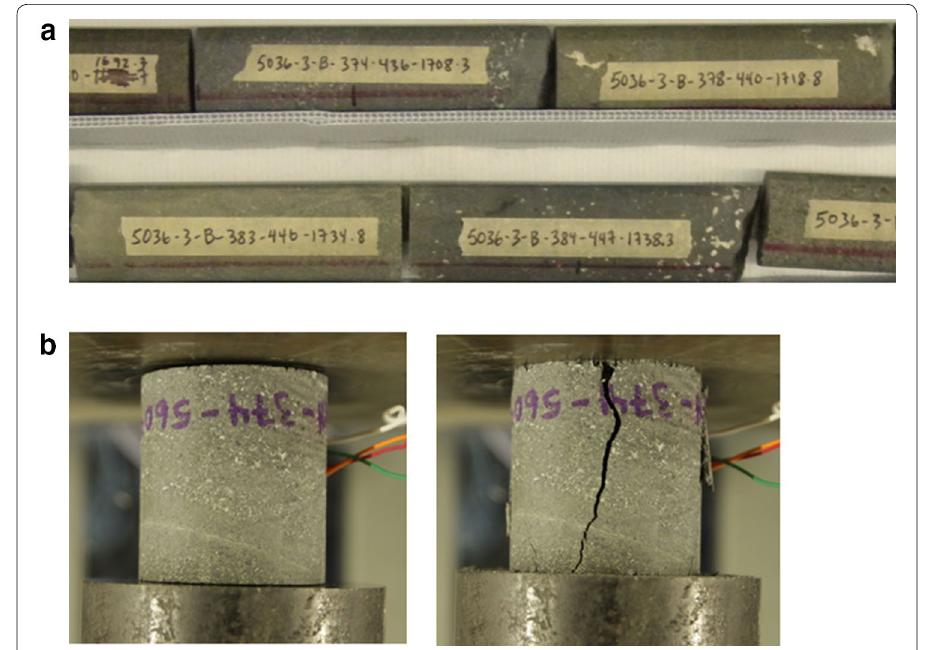
Fig. 7 Pictures of Unit 2: a core; b sample before and after UCS